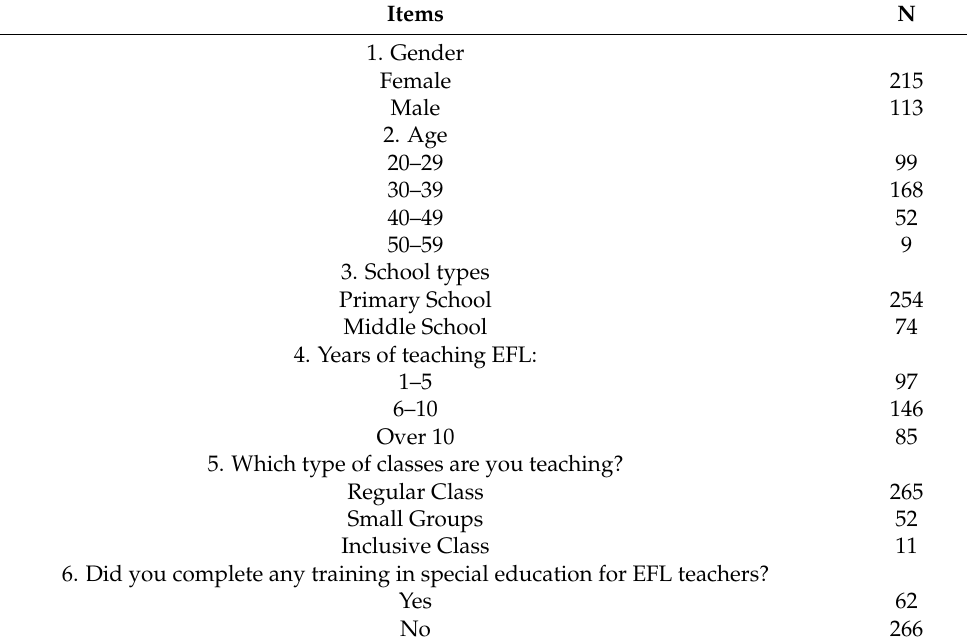
Table 1. Background information of the